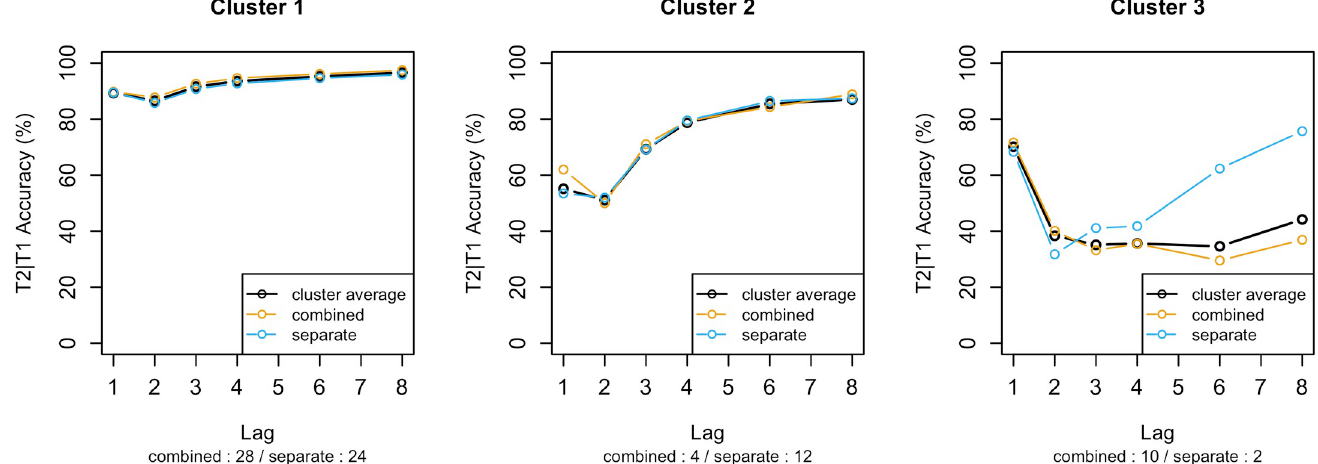
Fig 8. The three clusters present in the T2|T1 accuracy data. Indicated underneath the x-axis label are the number of participants included in this cluster per condition. Additionally, the dashed lines depict the cluster averages separately per instruction condition.